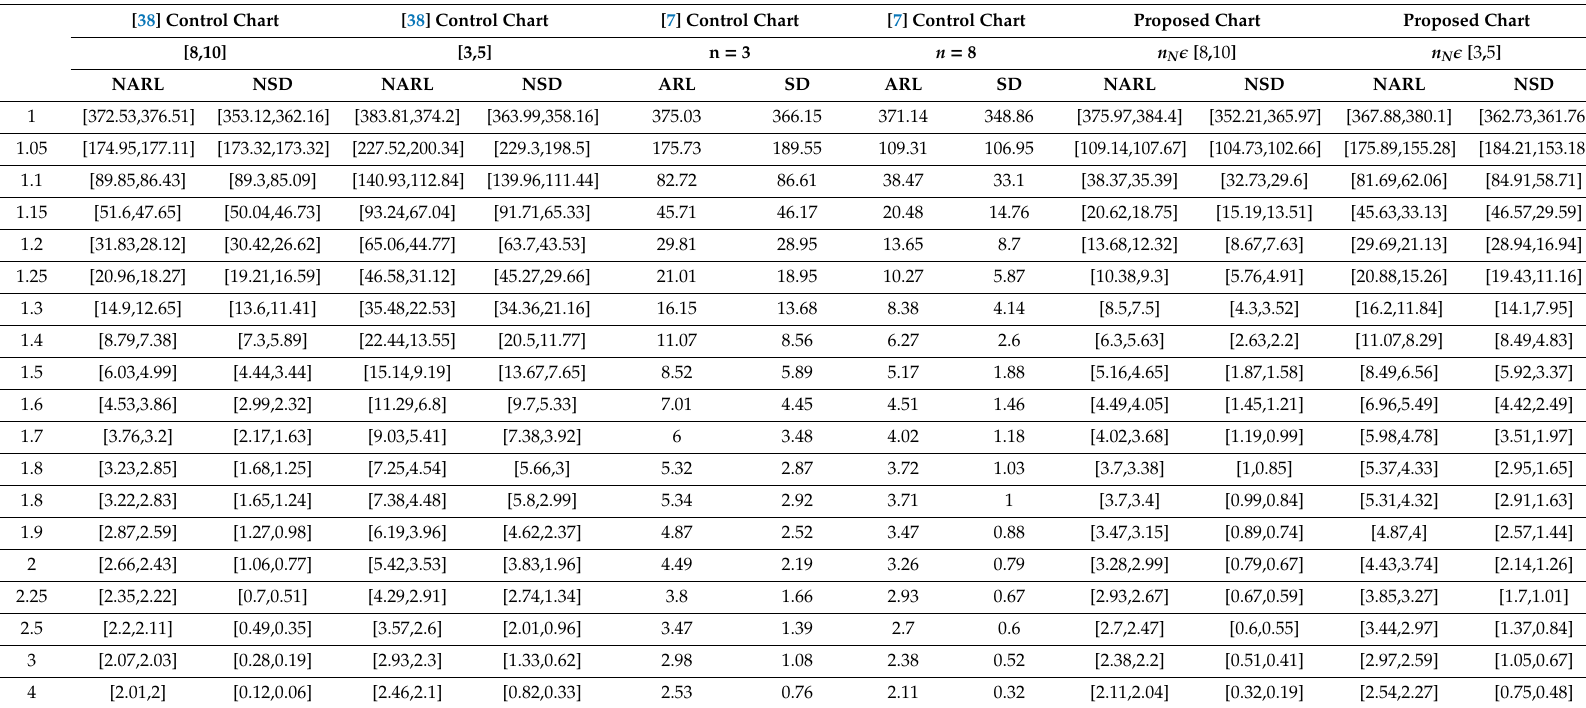
Table 8. The neutrosophic average run length (NARL) for the proposed and existing charts when λ N (cid:15) [0.08,